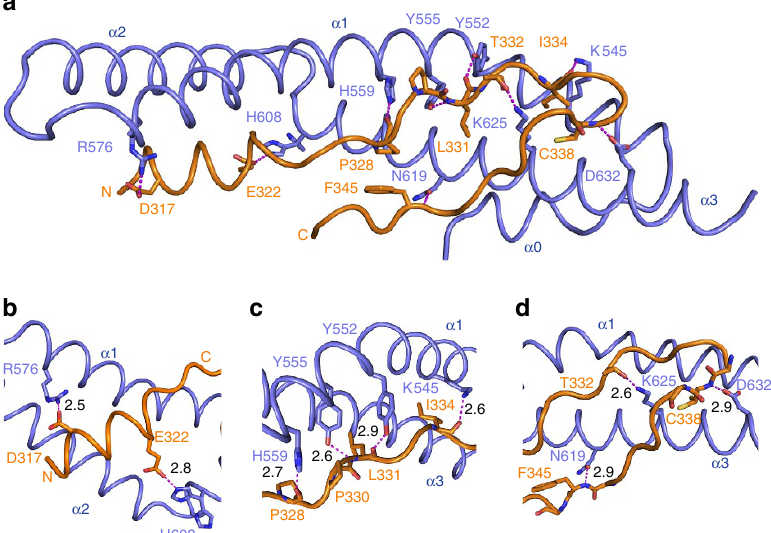
Figure 3 | Hydrogen bonding in the AFF4 ELLBow –ELL2 Occ complex. ( a ) Overview of the network of hydrogen bonds. The residues involved in the hydrogen bonding are shown in stick. Hydrogen bonds are shown as magenta-coloured dashed lines. ( b – d ) Details of the hydrogen bonds. The length of the hydrogen bonds is indicated next to the dashed